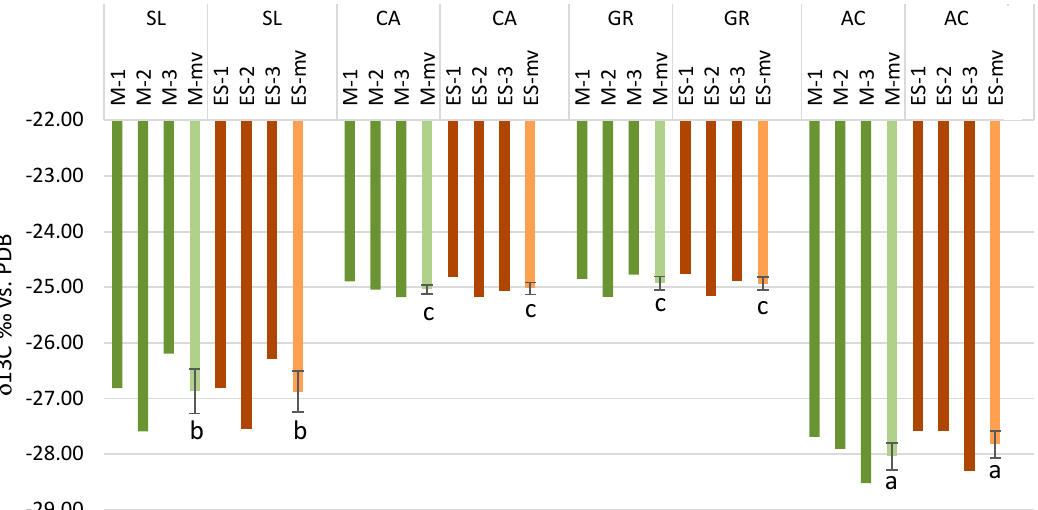
Figure 2. Comparison of δ ¹³C values (‰ vs. PDB) in must (M, 1-2-3 replicates) and extracted sugars (ES, 1-2-3 replicates) in the four vineyards (SL, Santa Lucia; CA, Calvese; GR, Grottole; AC, Acquefredde). Raw data, mean values (mv), and standard errors are shown. Different letters correspond to significant differences among vineyards according to Duncan’s multiple comparison tests of one-way ANOVA.